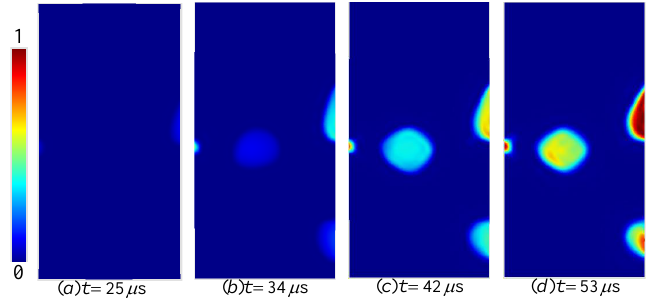
Figure 11. The evolution of damage field for the low amplitude load and cohesion realization with l c = 40 mm at times: ( a ) 25 µ s, ( b ) 34 µ s, ( c ) 42 µ s, and ( d ) 53 µ s.